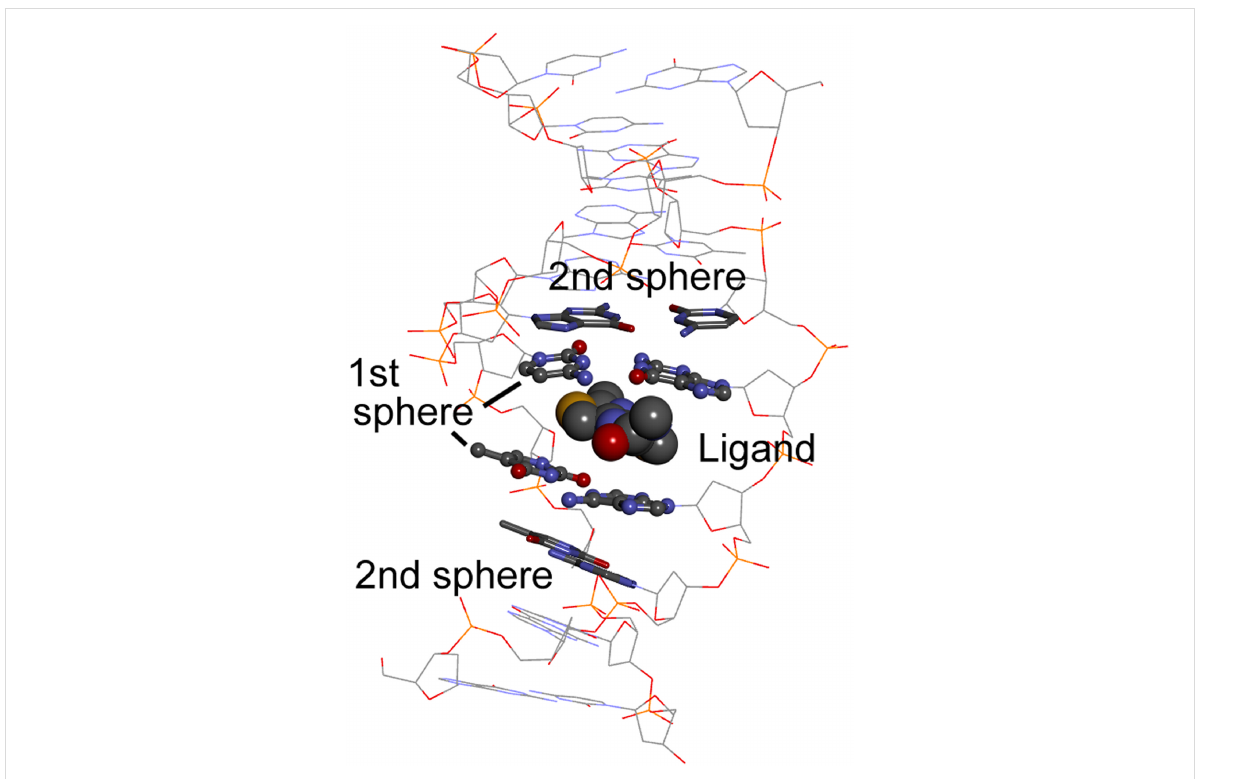
Figure 12: Minimal model to be considered to simulate the ICD spectrum of an intercalated ligand. ICD will be dominated by the intrinsic chirality of the ligand plus the nondegenerate exciton coupling with the most immediate nucleobase pairs (1st sphere). The following nucleobase pairs (2nd sphere) may possibly be neglected in the ECD calculations, but not in the input geometry